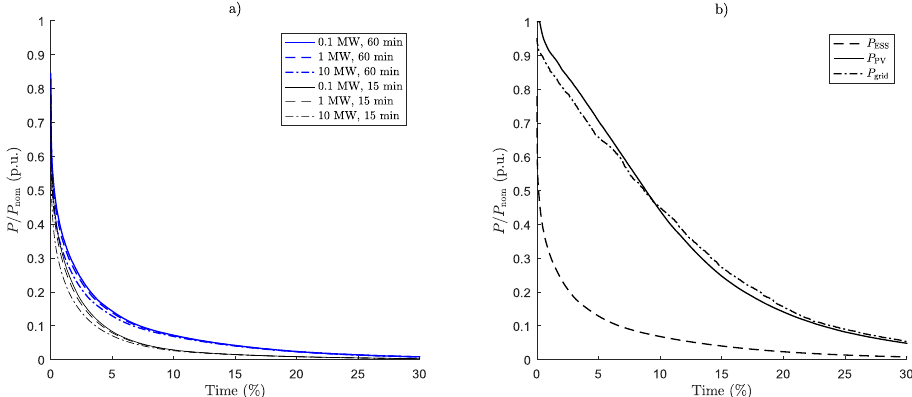
Figure 6. ( a ) Probability density distributions of ESS power requirements for the studied PV generators and ISP times; ( b ) ESS power requirement, PV generator power and grid feeding power probability density distributions for the 10 MW PV generator using 60 min ISP time and observation period.